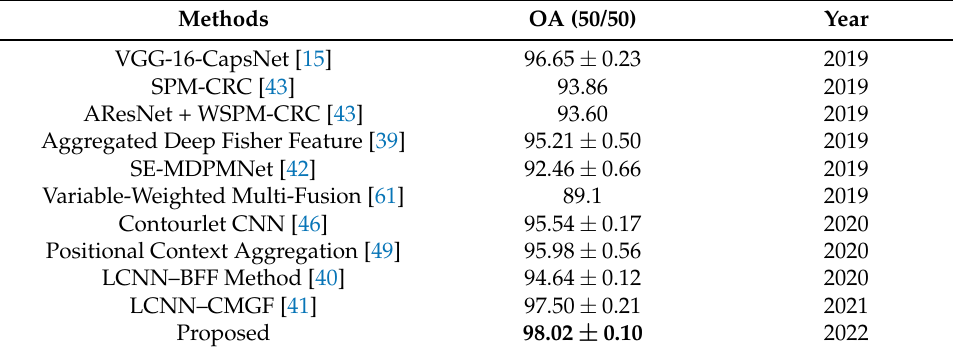
Table 8. OA comparison on RSSCN